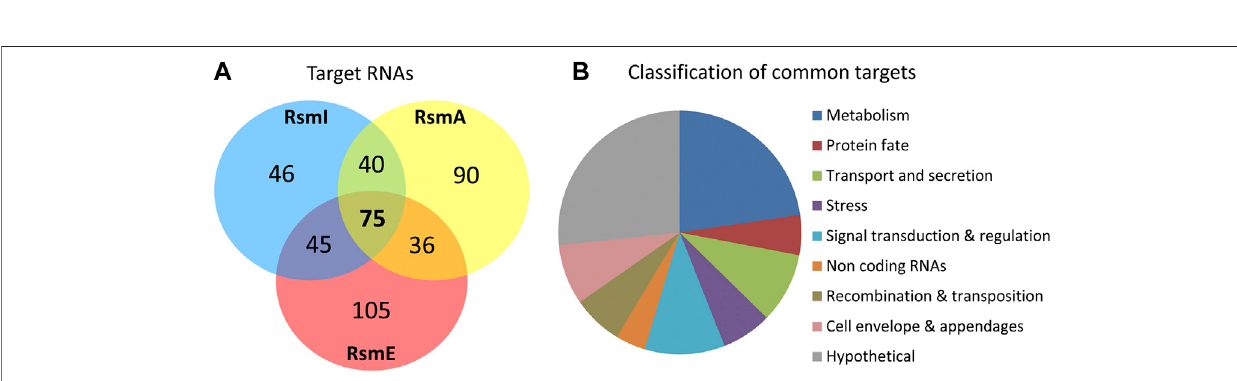
Frontiers in Molecular Biosciences |